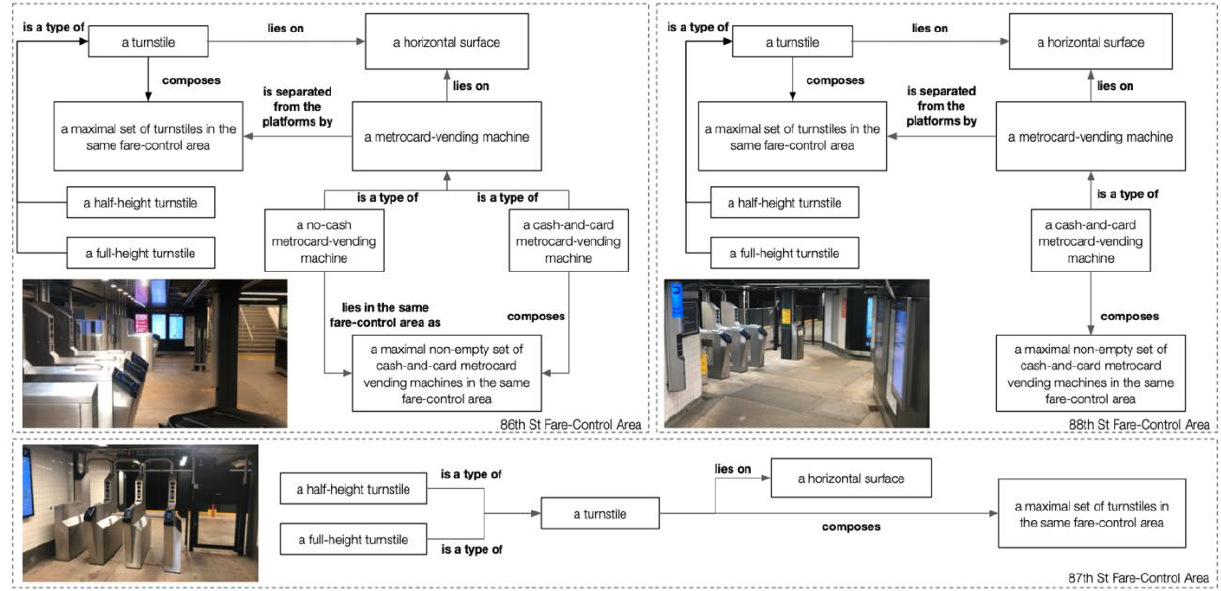
Figure 5. Ologs representing each of the three fare-control areas in the 86th St-Central Park West subway station individually. Some entities from Figure 2 cannot be present in some of these ologs because in the restricted region of a single fare-control area there exist no real-world examples of that entity. The 88th St entrance has no cash-only vending machine, whereas the 87th St entrance offers no vending machines at